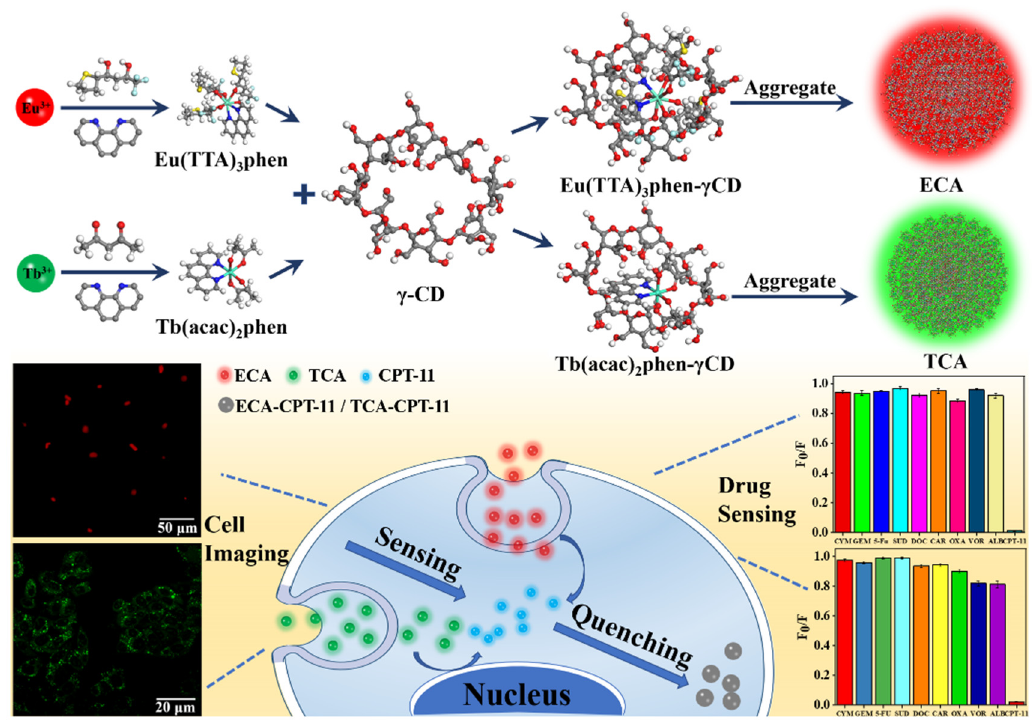
Figure 1. Schematic illustration showing γ -CD encapsulation of Eu 3+ /Tb 3+ complexes and selective detection of CPT-11.